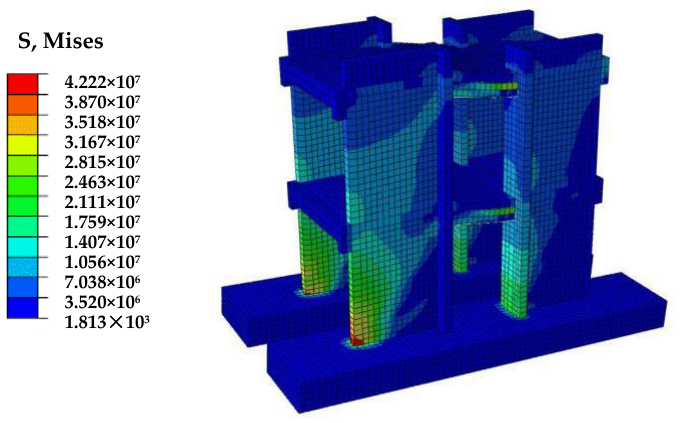
Figure 11. Stress distribution of spatial structure specimen of the prefabricated ECC/RC combined shear wall.